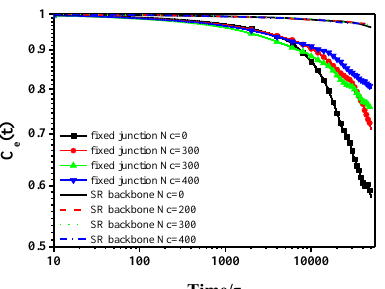
Figure 4. The end-to-end autocorrelation function of backbone in fixed junction systems and SR systems.